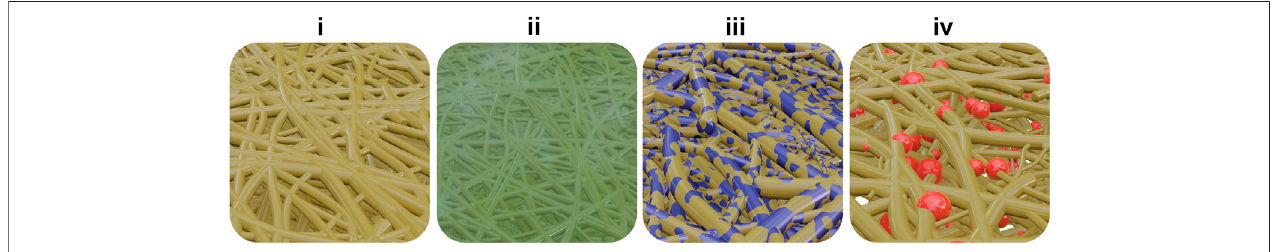
FIGURE 5 | Schematic representation of the main variations of cellulose PEMs at the focus of this study: 1) pristine nanocellulose; 2) polymer blends; 3) chemically modi fi ed cellulose; 4) blends with small molecules.